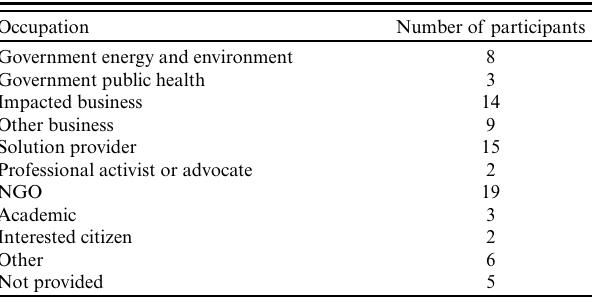
Table 1. Occupations of the participants in the Toolbox workshop at the West Michigan Climate Resiliency